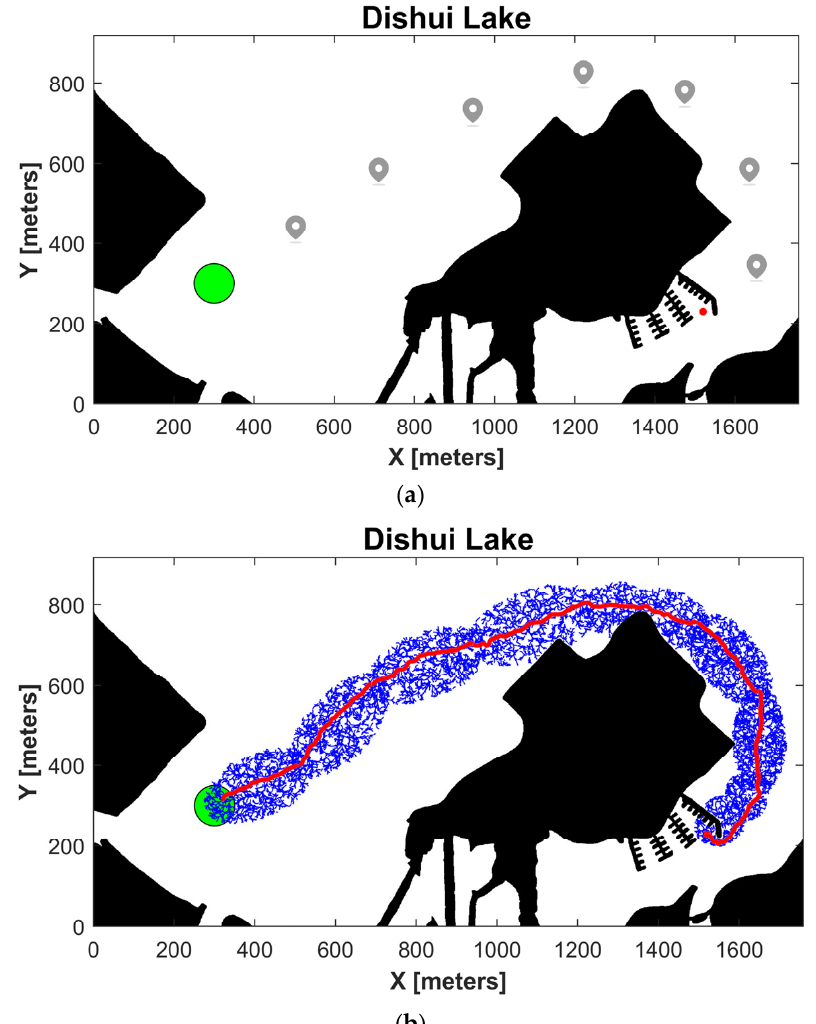
Figure 13. Simulation result in the Dishui Lake scenario: ( a ) diagram of intermediate waypoints; ( b ) global motion planning result for spRRT ‐ Informed.